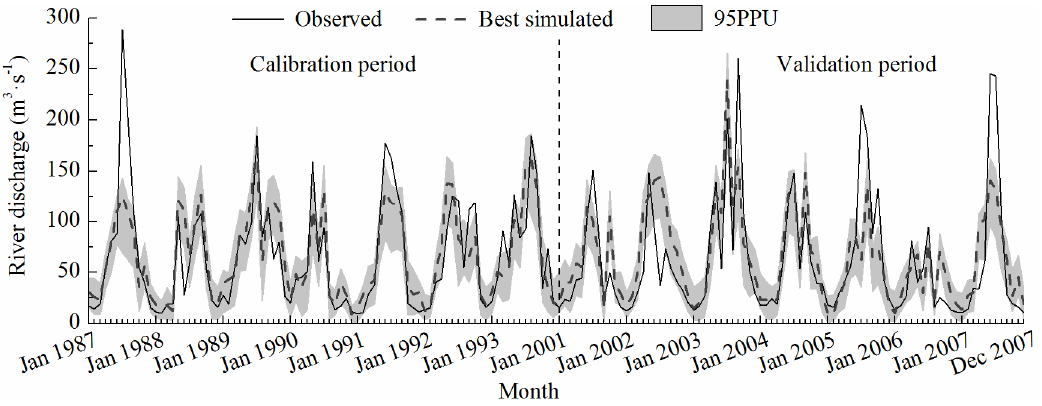
Figure 4. Observed, best simulated hydrographs and 95PPU band in calibration and validation periods.